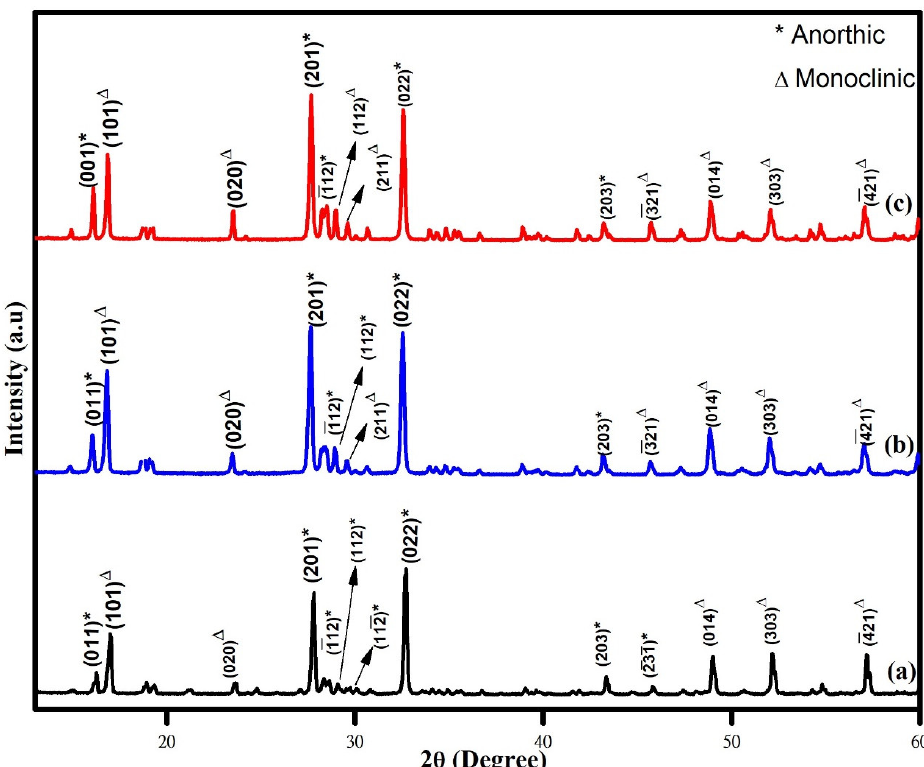
Figure 1. XRD pattern of ( a ) phthalic-acid-, ( b ) citric-acid-, and ( c ) oxalic-acid-assisted WO 3 nanoparticles.